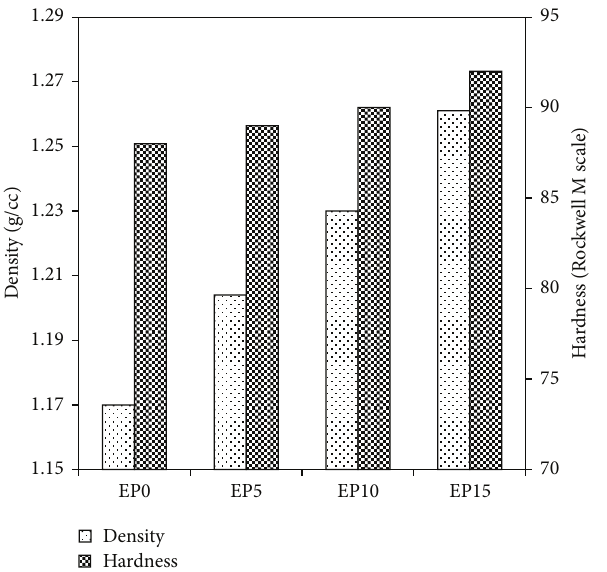
Figure 4: Density and hardness of neat epoxy and epoxy/PTW composites.